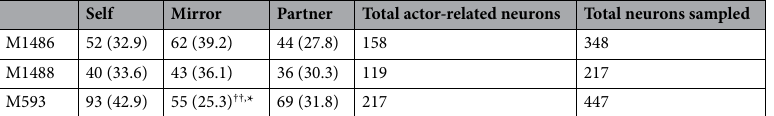
Table 1. Number of actor-related neurons in PMv. Values in parentheses denote the percentage of total actor- related neurons. †† P < 0.01, M1486 vs. M593; * P < 0.05, M1488 vs. M593; chi-square test.